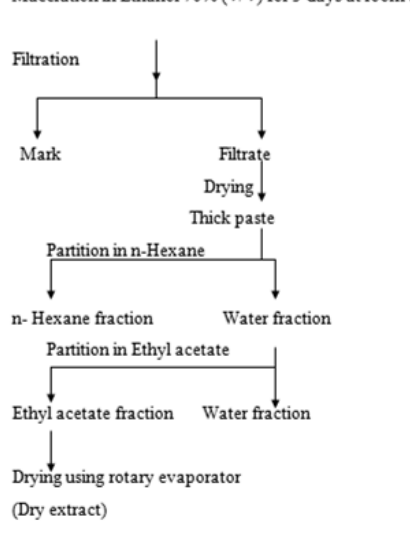
Figure 2: General scheme for method (No. 1) for extraction of Flavonoids from Vitex agnus- castus